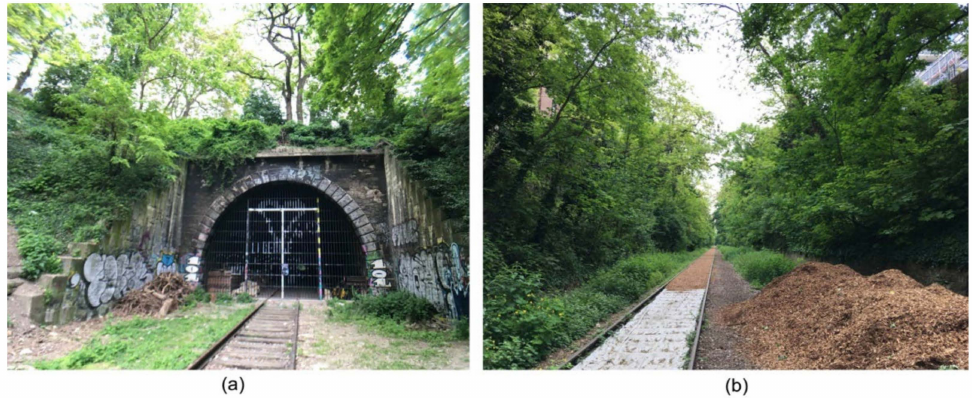
Figure 1. ( a ) Abandoned railway in the center of Paris (La Petite Ceinture); ( b ) reconstruction of the old